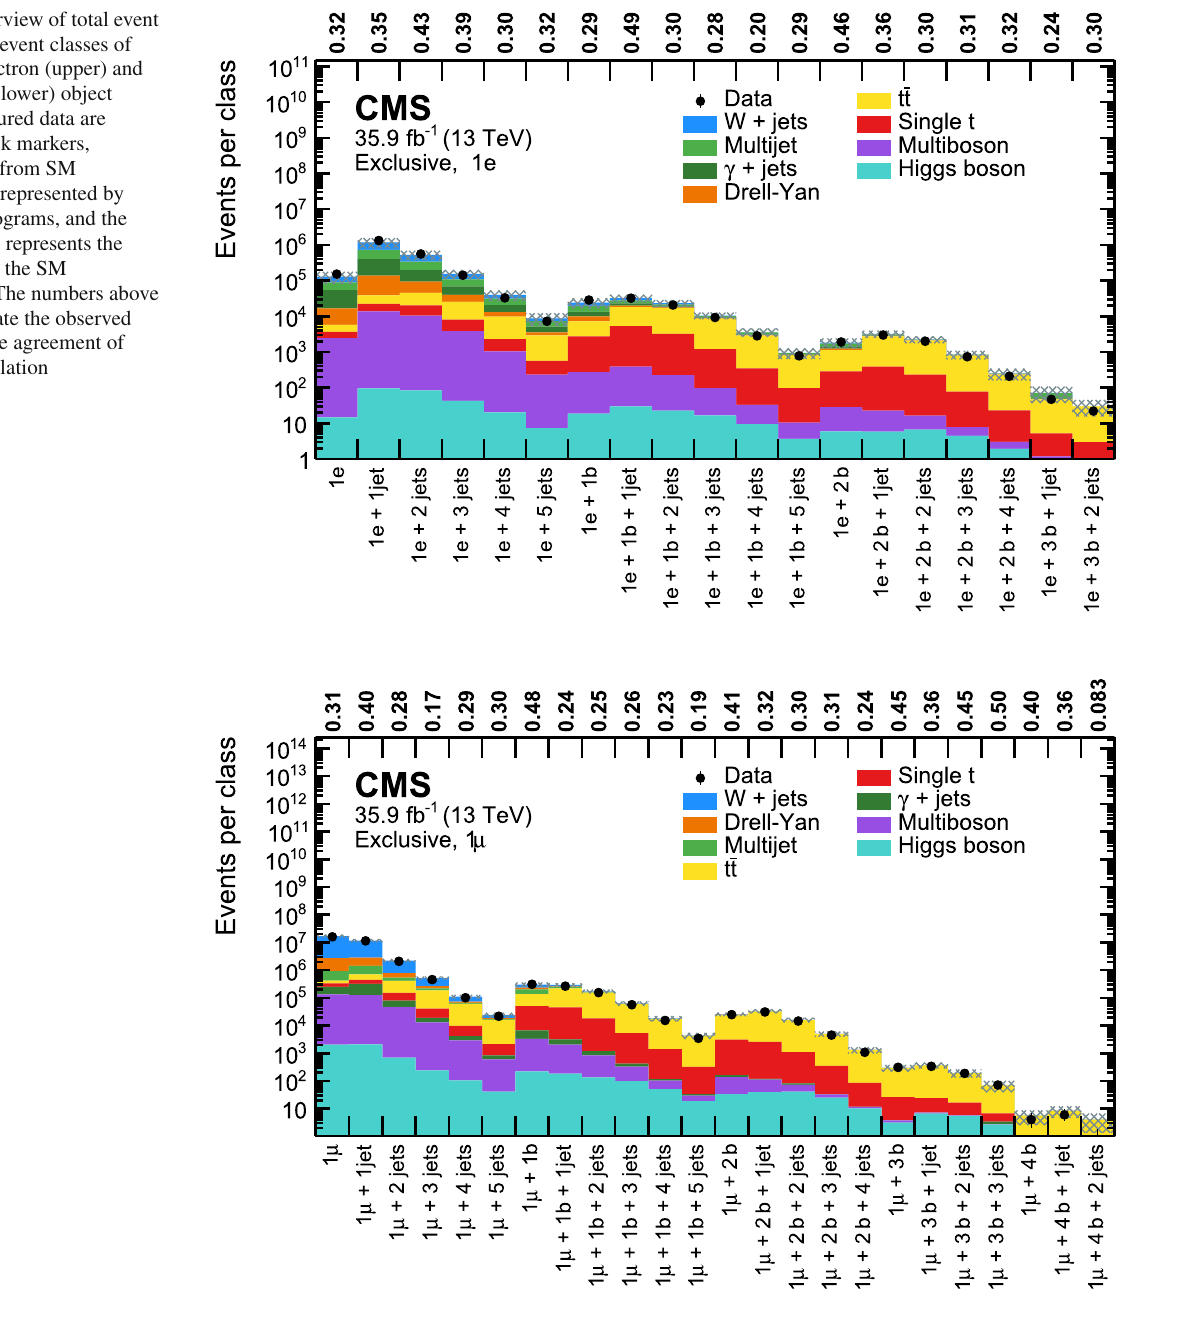
Fig. 14 Overview of total event yields for the event classes of the single-electron (upper) and single-muon (lower) object groups. Measured data are shown as black markers, contributions from SM processes are represented by coloured histograms, and the shaded region represents the uncertainty in the SM background. The numbers above the plot indicate the observed p value for the agreement of data and